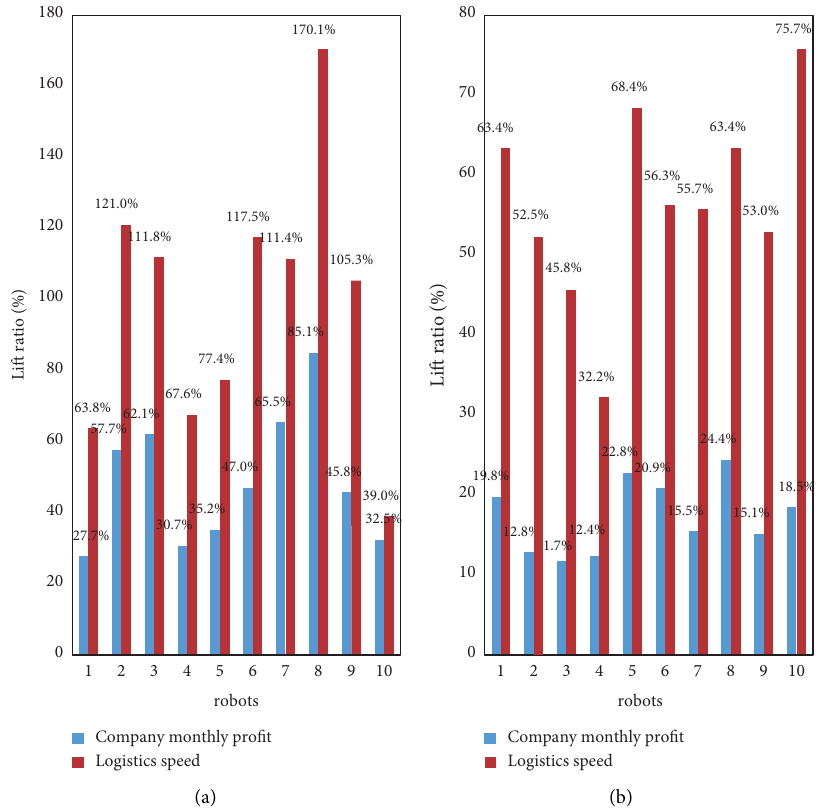
Figure 6: Changes in logistics management efciency. (a) Te frst set of experiments. (b) Te second set of